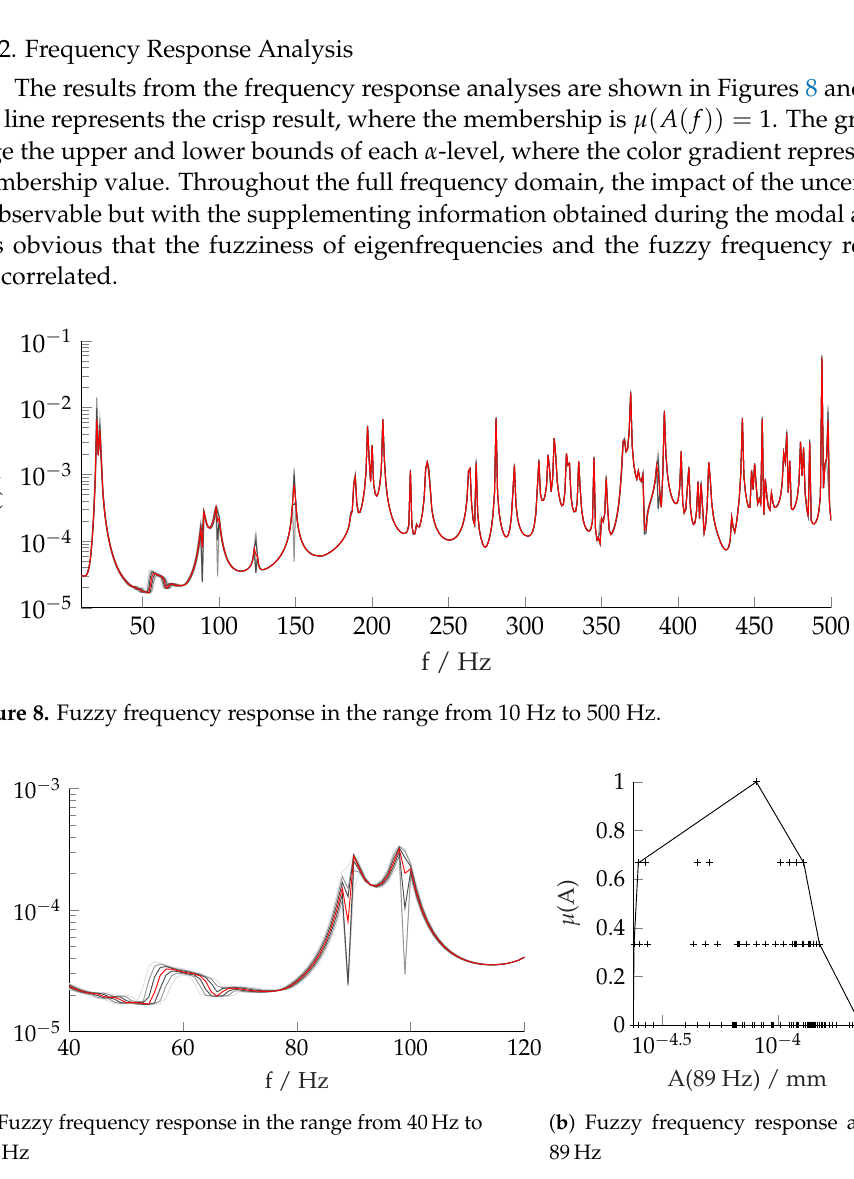
Figure 9. A detailed look on the fuzzy frequency response in the range from 40 Hz to 120 Hz